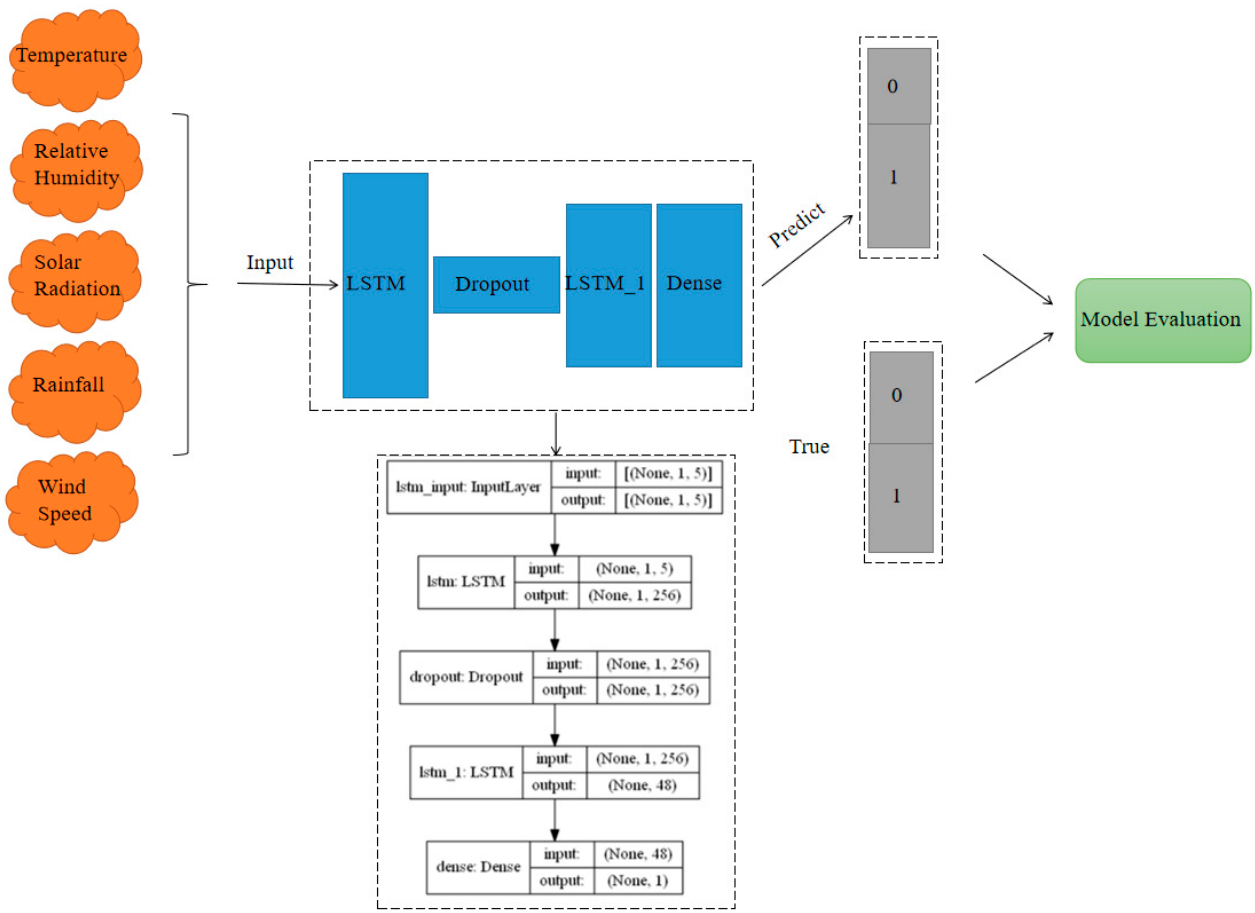
Figure 2. The structure of the hot pepper disease occurrence prediction model.